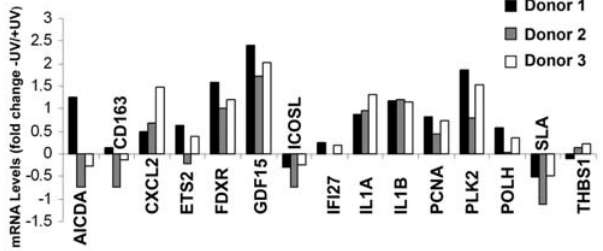
Figure 1. Analysis of gene expression in UV-irradiated human DCs by RT-PCR. Real-time semiquantitative TaqMan RT-PCR was performed to validate differential gene expression induced by UV irradiation in human monocyte-derived dendritic cells (DCs) in culture. DCs (obtained from 3 donors) were untreated or exposed to solar- simulated UV radiation (3.7 J/cm 2 UVA + 0.3 J/cm 2 UVB). Total RNA was extracted after a further 6 h in culture. Primer sequences are shown in Table S1. Expression levels were normalized to 18s RNA. Bars correspond to log10 of fold down-regulation or up-regulation compared with non-irradiated